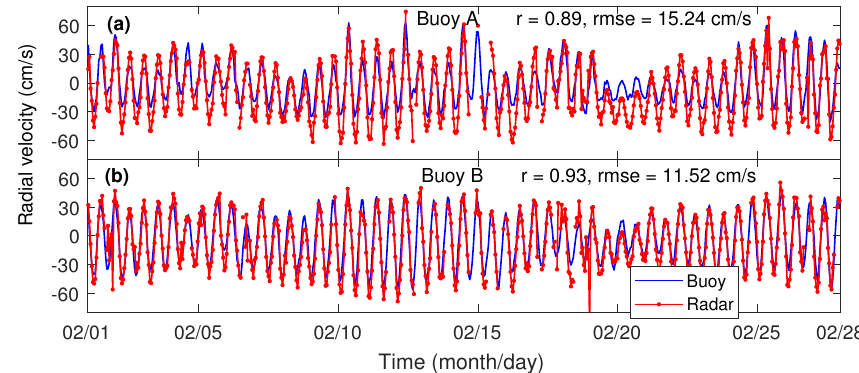
Figure 9. Comparison of hourly averaged radar-sensed radial velocities derived from the proposed calibration method with those recorded by the buoys (Figure 8). ( a ) radial current velocities comparison at buoy A; ( b ) radial current velocities comparison at buoy B. Correlation coefficient (r) and root-mean-square error (rmse) are shown in the top of each panel.